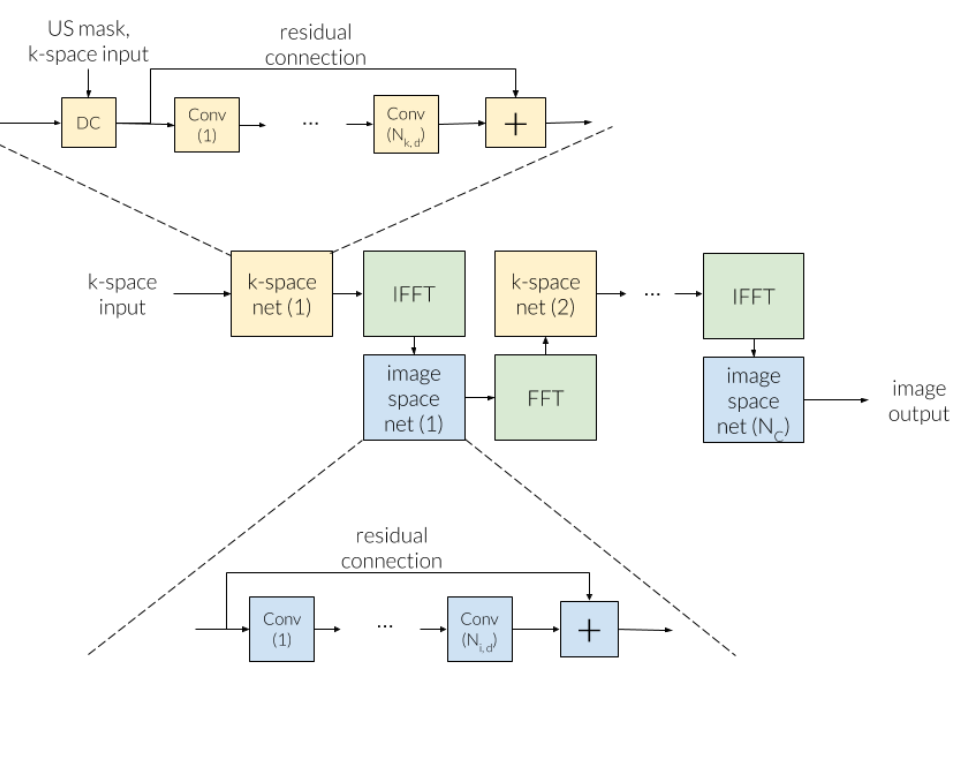
Figure 2. The common backbone between the Cascade net, the KIKI-net, and the PD-net. US mask stands for under-sampling mask. DC stands for data consistency. (I)FFT stands for (Inverse) Fast Fourier Transform. N k , d is the number of convolution layers applied in the k-space. N i , d is the number of convolution layers applied in the image space. N C is the total number of alternations between the k-space and the image-space. It is to be noted that in the case of PD-net, the data consistency step is not performed, the Fourier operators are performed with the original under-sampling mask, and a buffer is concatenated along with the current iteration to allow for some memory between iterations and to learn the acceleration (in the k-space net—dual net—it is also concatenated with the original k-space input). In the case of the Cascade net, N k , d = 0, only the data consistency is performed in the k-space. In the case of the KIKI-net, there is no residual connection in the k-space. However, the k-space nets and image space nets could potentially be any kind of image-to-image neural network.